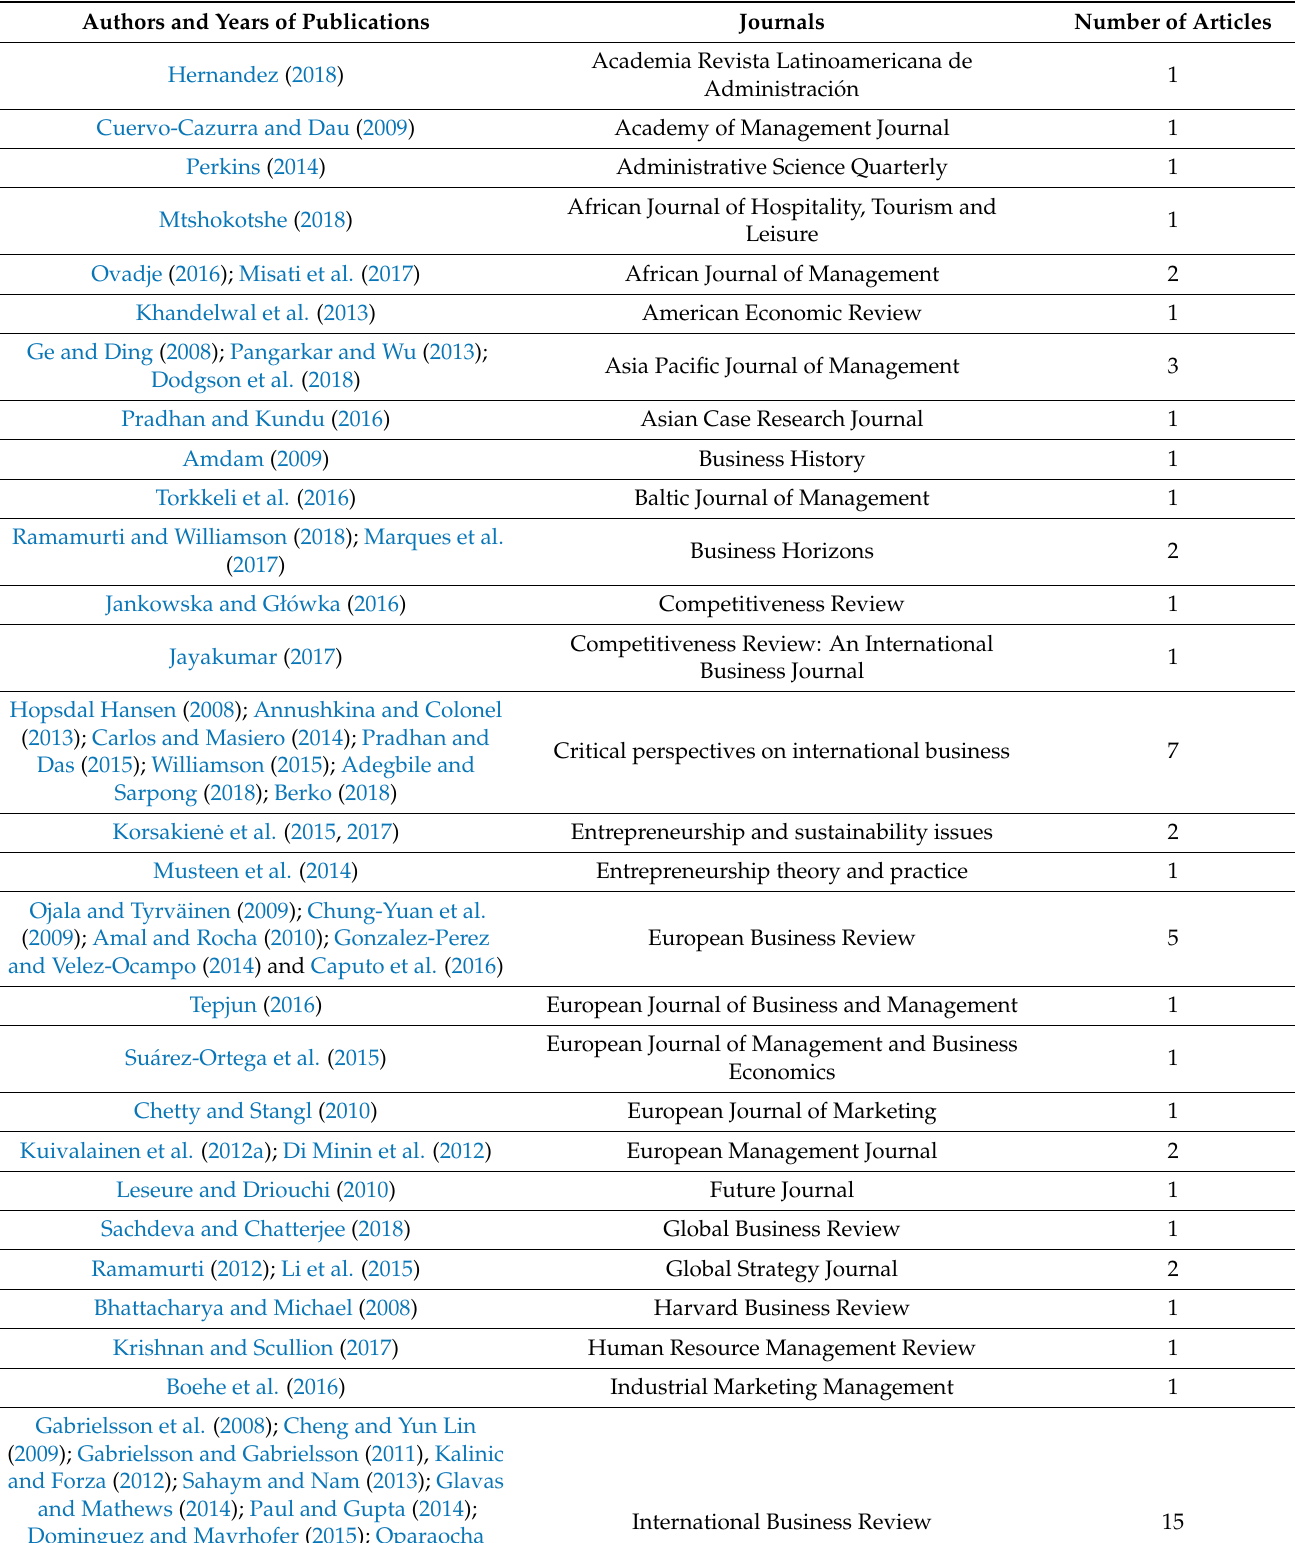
Table 1. Distribution of Articles by